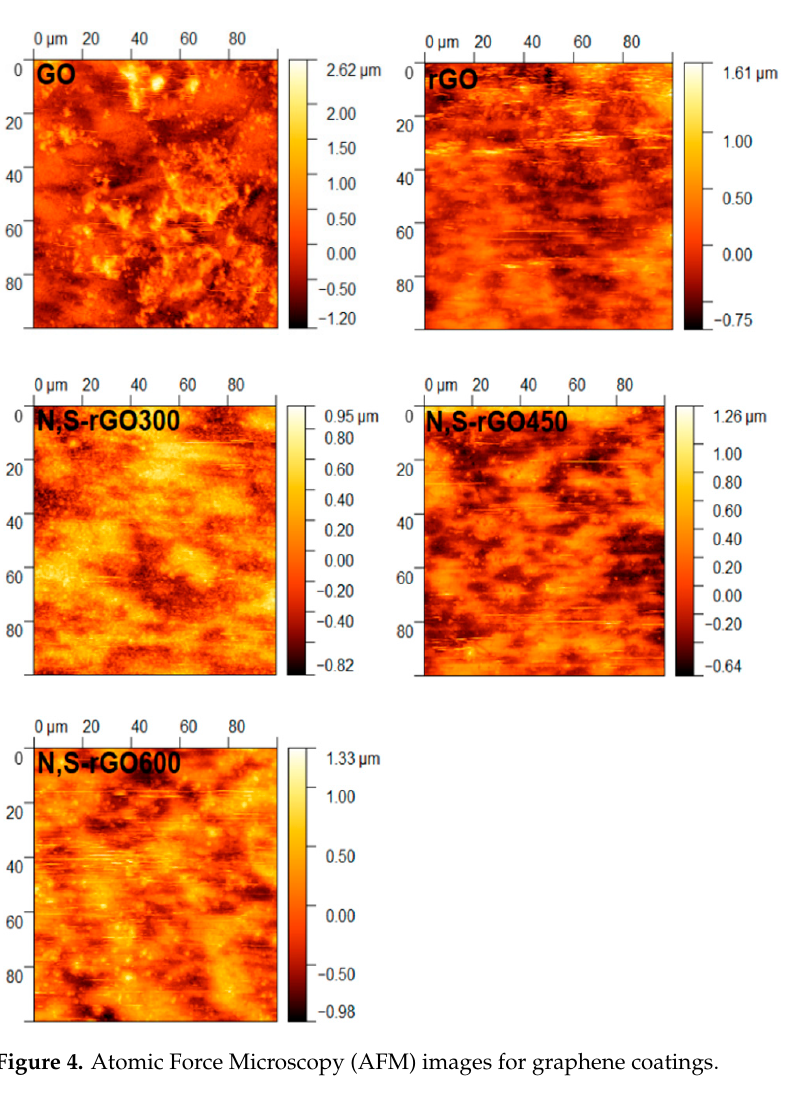
Table 3. Contact angle values and surface roughness parameters for graphene coatings. Coating